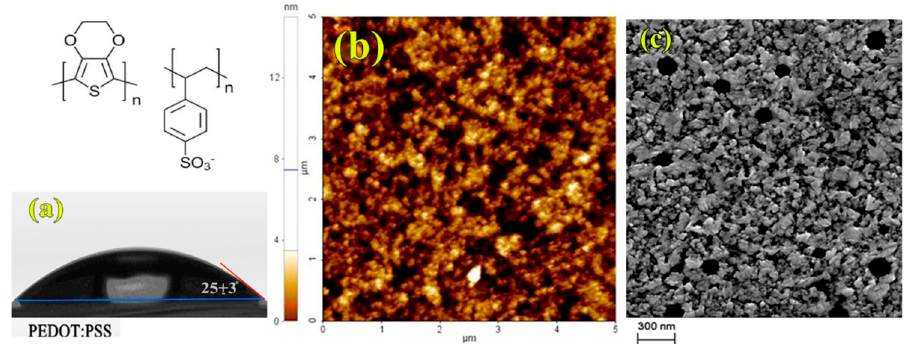
Figure 1. Water contact angle on PEDOT: PSS deposited on Glass/Indium Tin oxide (ITO) ( a ). Atomic Force Microcopy (AFM) images (5 × 5 nm) of Perovskite/starch film deposited on PEDOT: PSS film (Rq = 1.11 nm) ( b ). A Scanning Electron Microscopy (SEM) image of perovskite / starch deposited on PEDOT: PSS film ( c ).